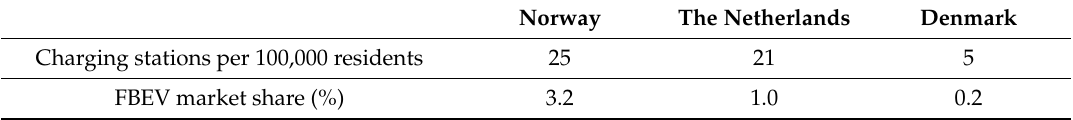
Table 5. Overview of charging station densities and FBEV market shares as of 2012 (Source: